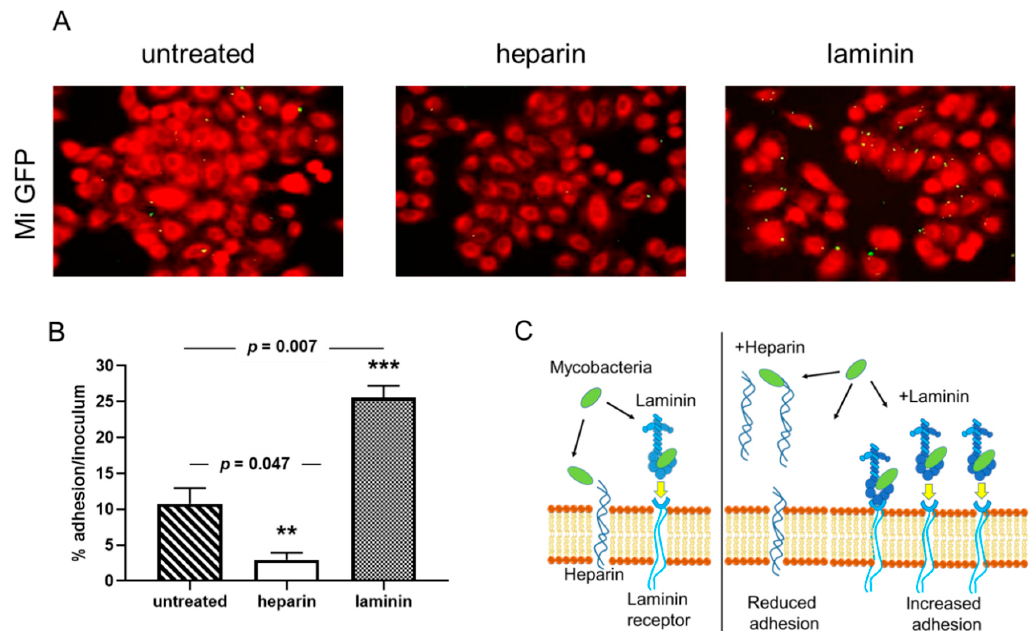
Figure 2. Cytoadherence of M. intracellulare ATCC13950 to A549 epithelial cells inhibited heparin and increased by laminin. A549 cells were infected by Green fluorescent protein (GFP)- and luciferase-producing M. intracellulare ATCC13950 in the presence or absence of heparin or laminin. ( A ) Fluorescence microscopy analysis of the A549 cells infected by M. intracellulare / GFPlux (green). The samples were fixed with PFA and stained with Evans Blue (red). Images taken with 40 × objectives represent the overlay of Evans Blue and GFP signals. ( B ) Quantification of M. intracellulare / GFPlux adherence by luciferase assays. The percentages of adhesion were calculated by the formula (cell-associated RLU / RLU of the inoculum) × 100. The graph shows the averages of triplicate samples from one representative of three independent experiments. ** p < 0.05; *** p < 0.01. The error bars represent the standard deviation. ( C ) The diagram gives an illustration of how bacteria bind to cells, either directly on the heparin present on the surface of cells or via laminin which then binds to its cell receptor. In the presence of exogenous heparin or laminin, the adhesion of the bacteria is inhibited Microorganisms 2020 , 8 , x FOR PEER REVIEW or increased.